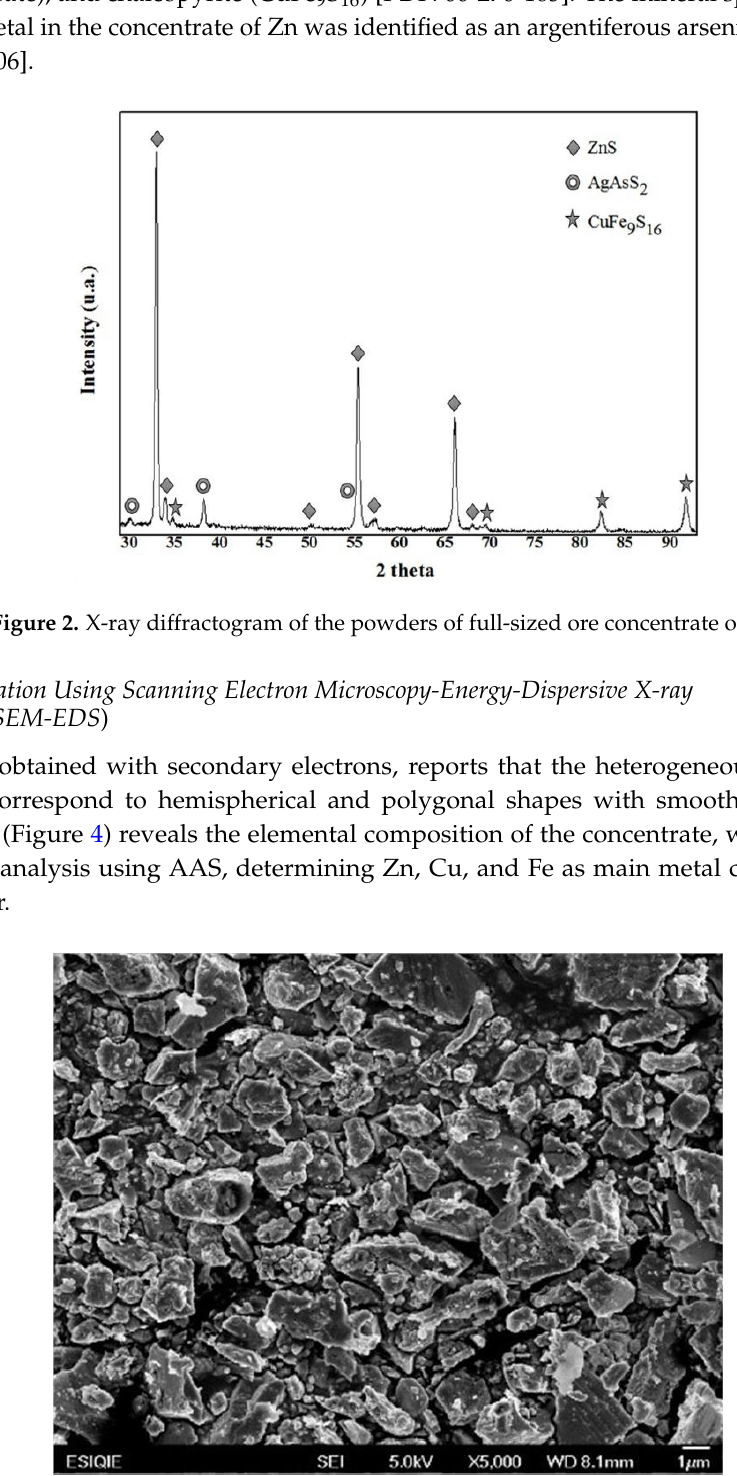
Figure 3. Micrograph of a powder sample of a Zn concentrate obtained using secondary electrons.